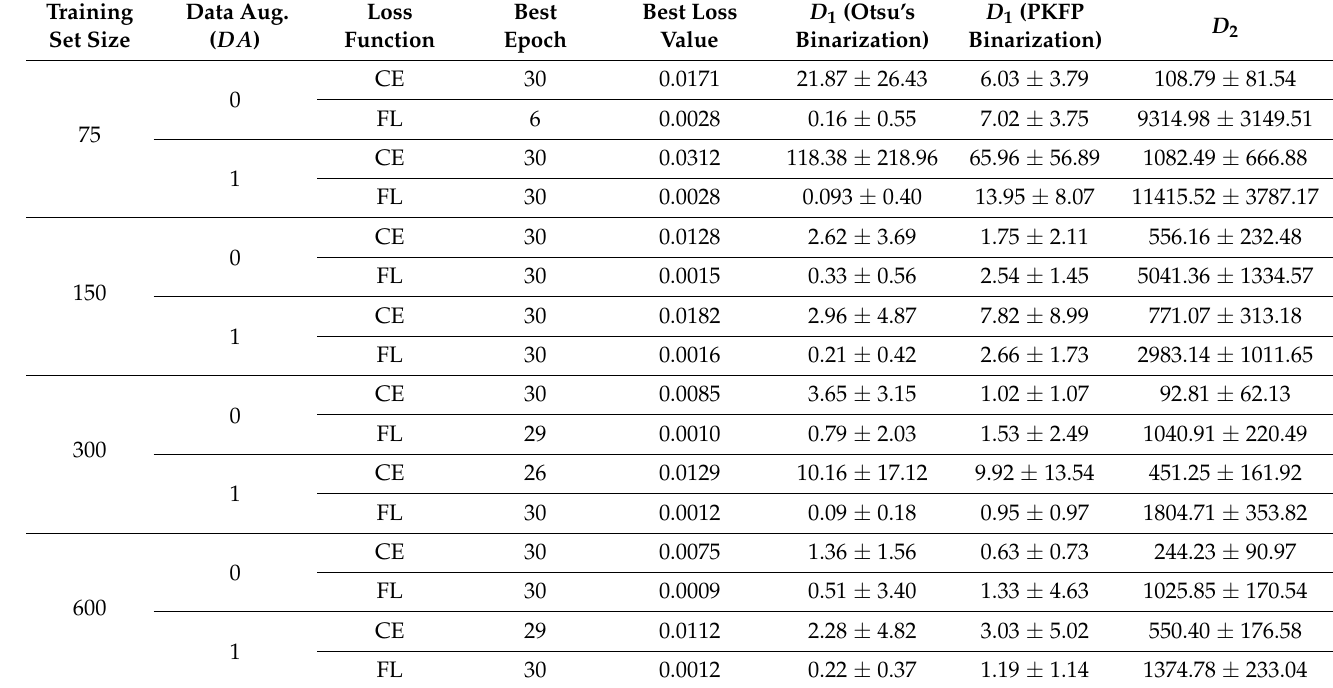
Table 1. Results of the 16 models considered in the evaluation of the U-Net